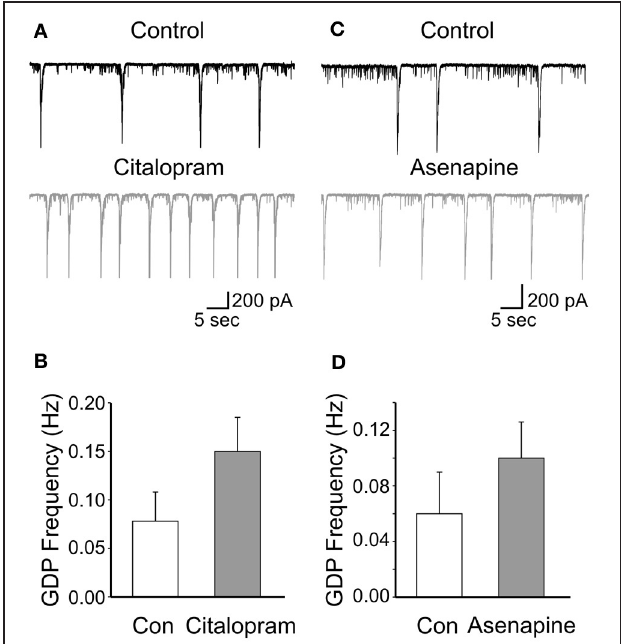
FIGURE 2 | Low concentrations of citalopram and asenapine enhance GDPs frequency. (A) GDPs recorded before and during application of citalopram (1 μ M). (B) Summary data for the results shown in A ( n = 5; p < 0 . 001). Each column represents the mean ± SEM. (C,D) as for (A,B) but for asenapine (0.2 μ M; n = 5; p = 0 . 02).